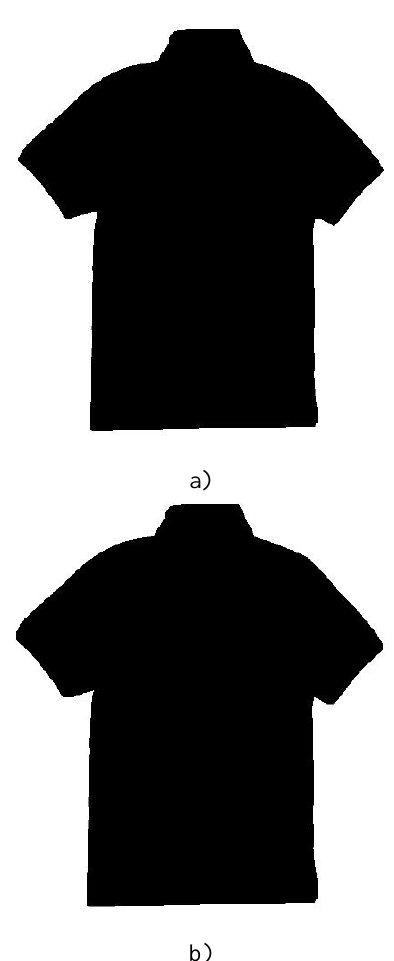
Figure 7. a) Eroded filter result, b) Dilate filter